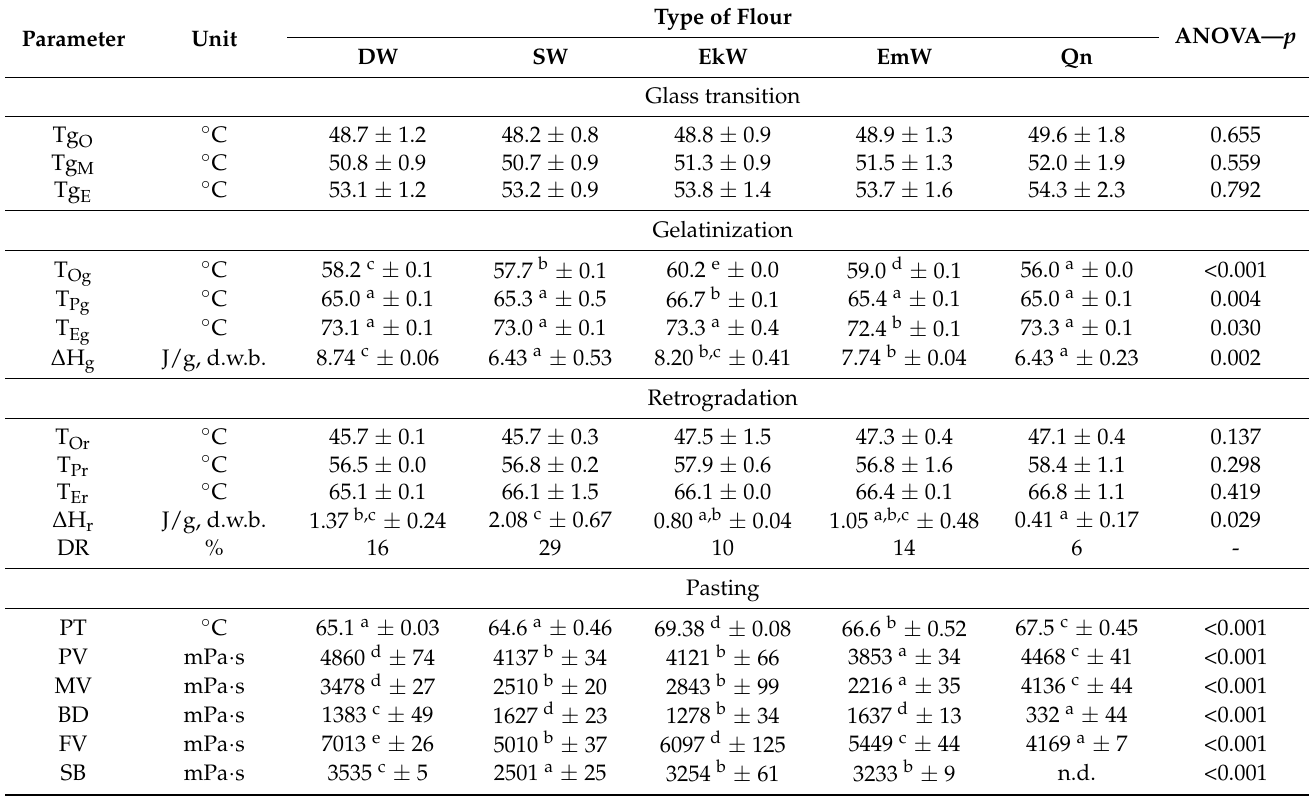
Table 2. Parameters of phase transitions and pasting characteristics of